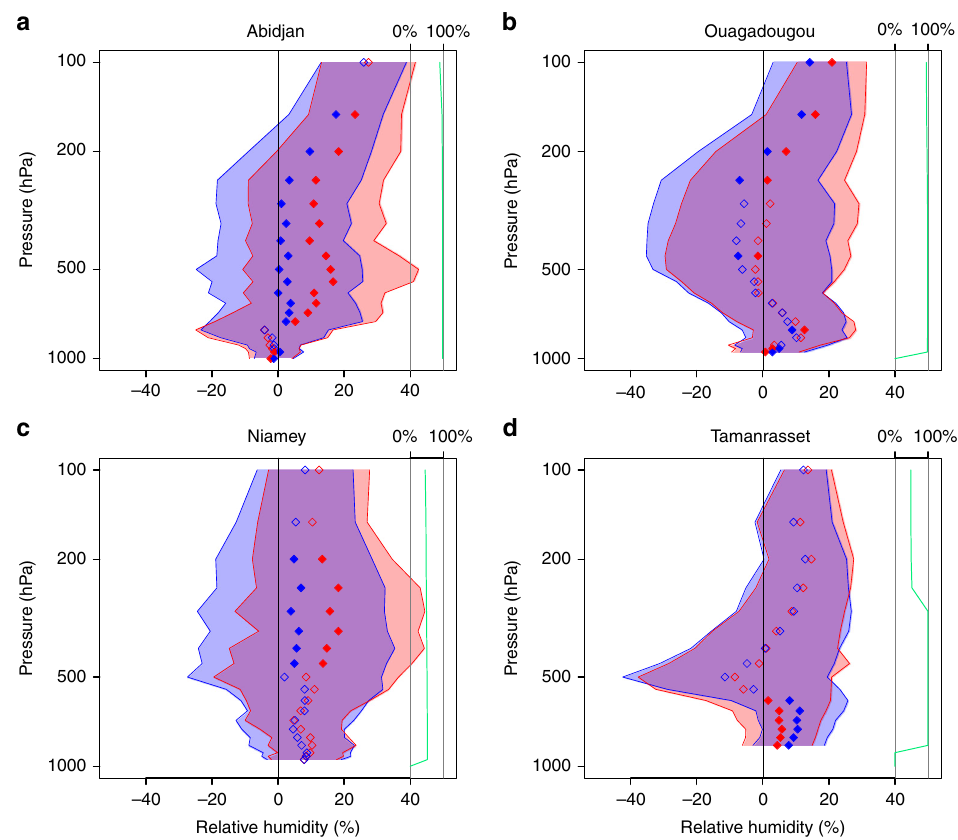
Fig. 2 Model evaluation against radiosondes for relative humidity. Bias of relative humidity compared to radiosonde data from Abidjan ( a ), Ouagadougou ( b ), Niamey ( c ) and Tamanrasset ( d ). Averaged over all 124 simulations, shaded areas show the mean bias ± standard deviation of model simulations employing the convection parameterisation (PARAM, red) and explicitly resolving convection (EXPLC, blue) for all available soundings during forecast days 2 – 5. The mean values of the bias are marked by red and blue diamonds, which are fi lled if the difference between EXPLC and PARAM is statistically signi fi cant on the α = 5% level and open otherwise. The scale to the right shows data availability in percent, that is, how many of the 124 days have at least one sounding a day at 00 or 12 UTC (Coordinated Universal